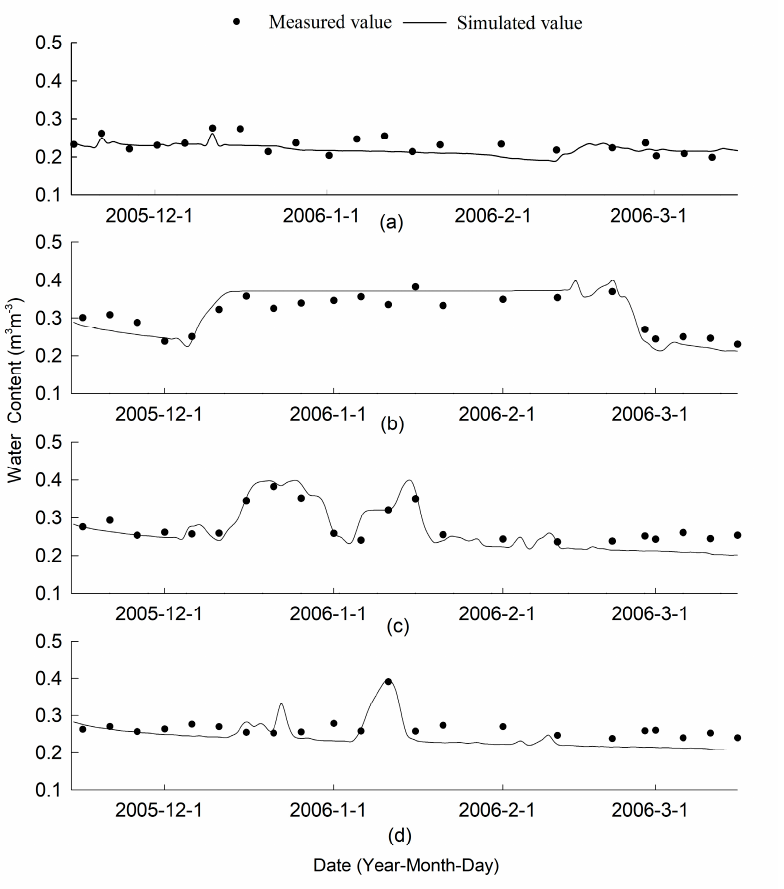
Figure 4. Comparison between the measured and simulated values of soil water content when ( a ) the soil depth of LD is 10 cm, ( b ) the soil depth of JG5 is 10 cm, ( c ) the soil depth of JG20 is 5 cm, and ( d ) the soil depth of JG30 is 5 cm.